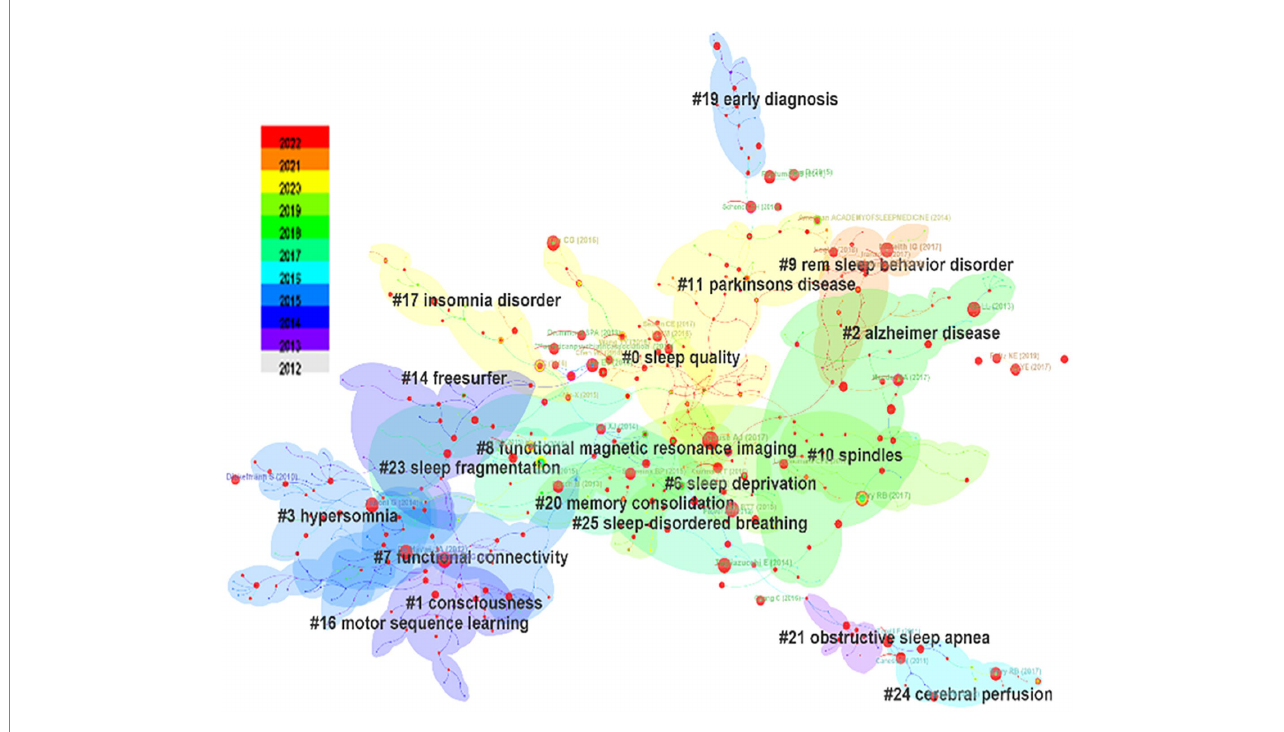
FIGURE 7 Co-citation clustering map of the